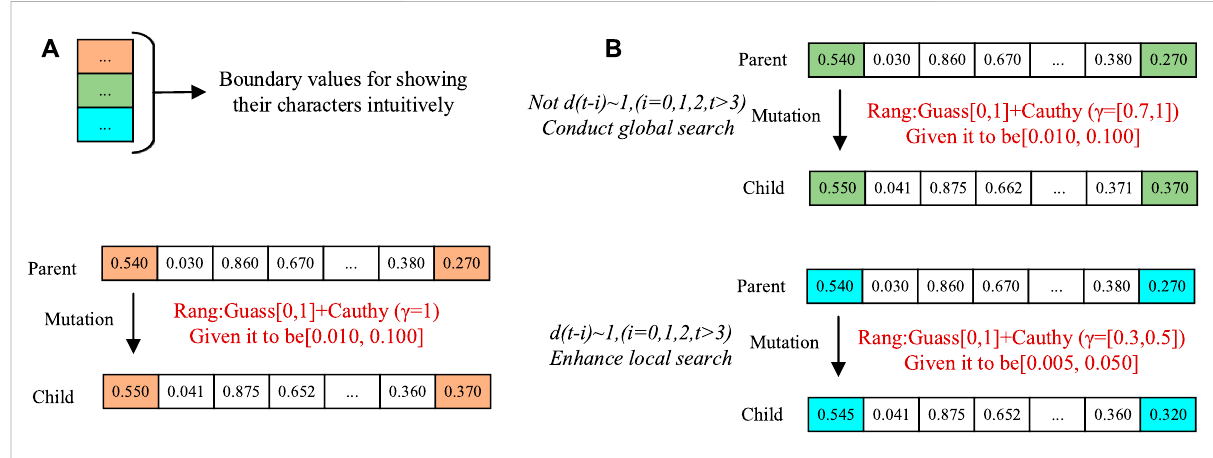
FIGURE 5 The mutation processes of different methods under real number coding: (A) Standard Guass-Cauchy mutation, (B) Gauss- γ Cauchy mutation.